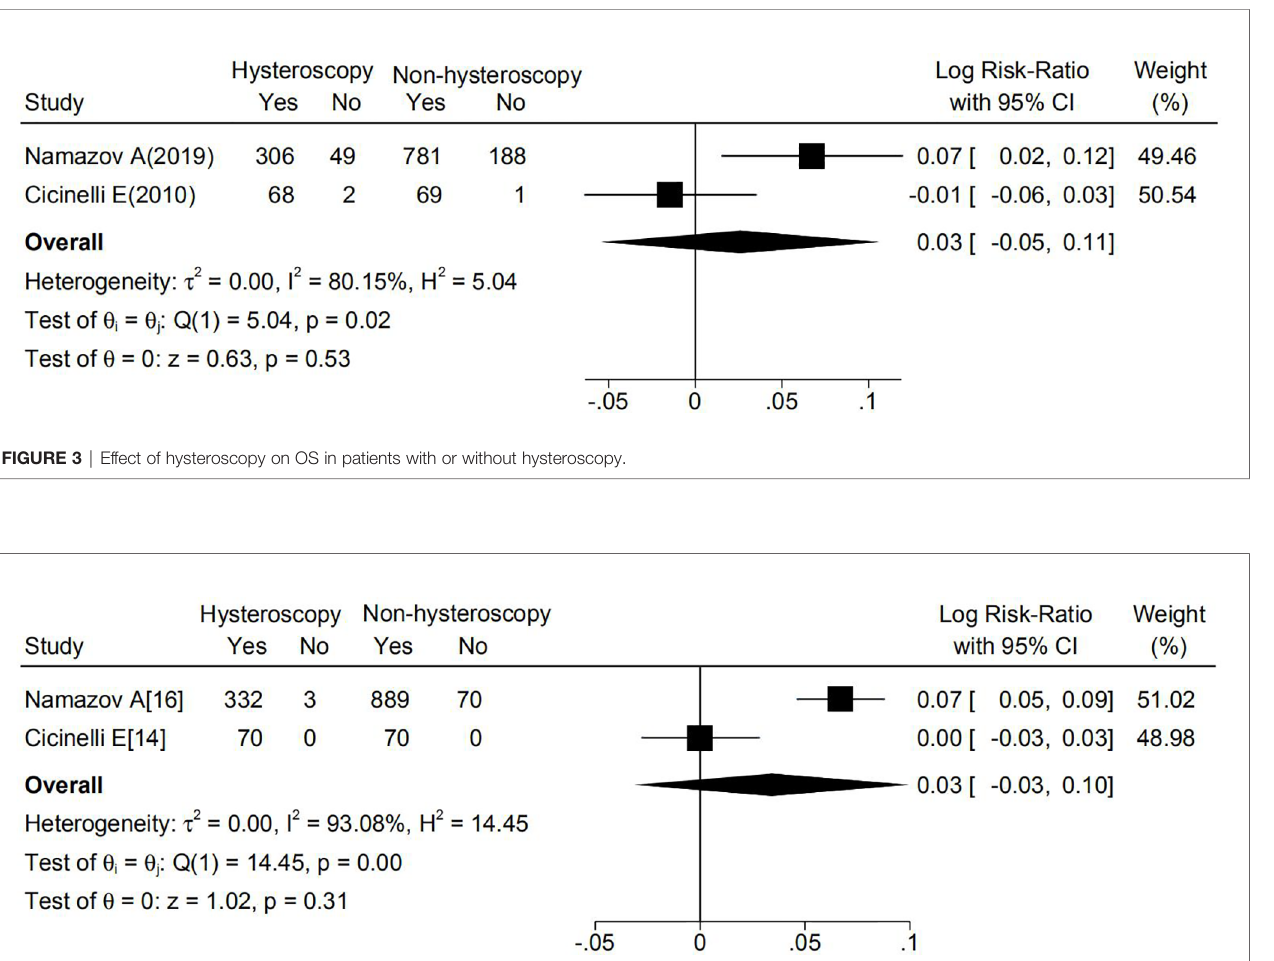
FIGURE 4 | Effect of hysteroscopy on DSS in patients with or without